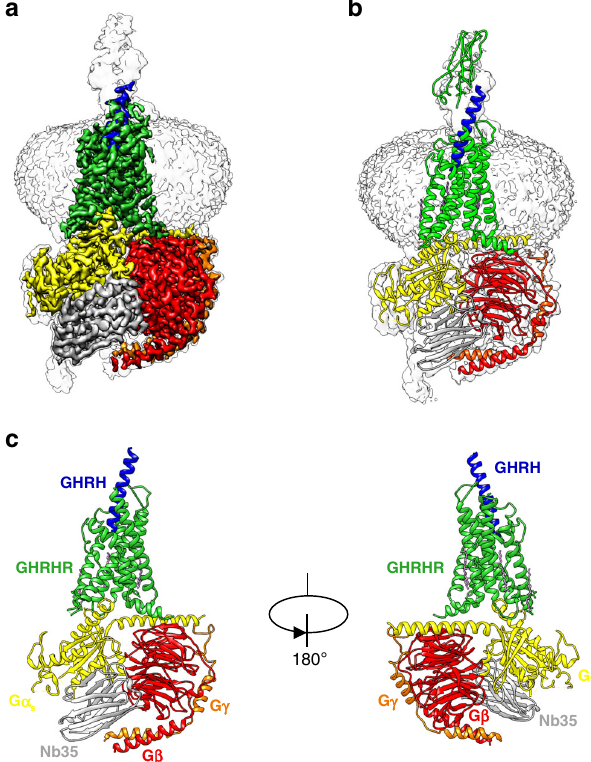
Fig. 1 The overall cryo-EM structure of GHRH – GHRHR – G s complex. a Cryo-EM density map that illustrates the GHRH – GHRHR – G s complex and the disc-shaped micelle. The unsharpened cryo-EM density map at the 0.005 threshold shown as light gray surface indicates a micelle diameter of 10 nm. The colored cryo-EM density map is shown at 0.028 threshold. b GHRH – GHRHR – G s complex model and GHRHR ECD crystal structure model docked into the cryo-EM map. c Cartoon representation of the GHRH – GHRHR – G s complex is shown with annular lipids in purple stick representation. Lime green, GHRHR; blue, GHRH; yellow, G s Ras-like domain; red, G β ; orange, G γ ; gray, Nb35; plum, lipid, and